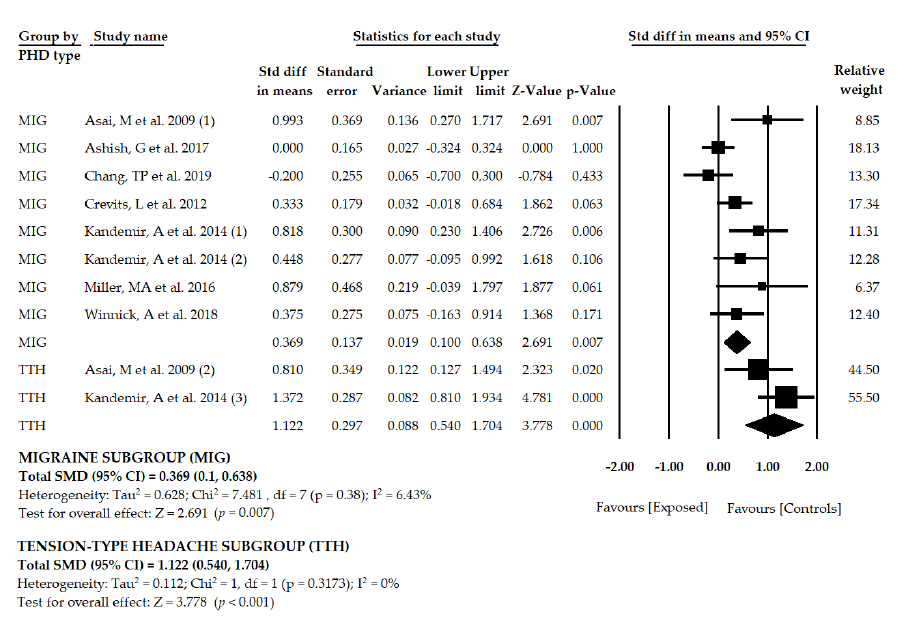
Figure 4. Forest plot for the perception of visual verticality, assessed with the SVV test, in subgroups of patients with migraine or tension-type headache . patients with migraine or tension-type